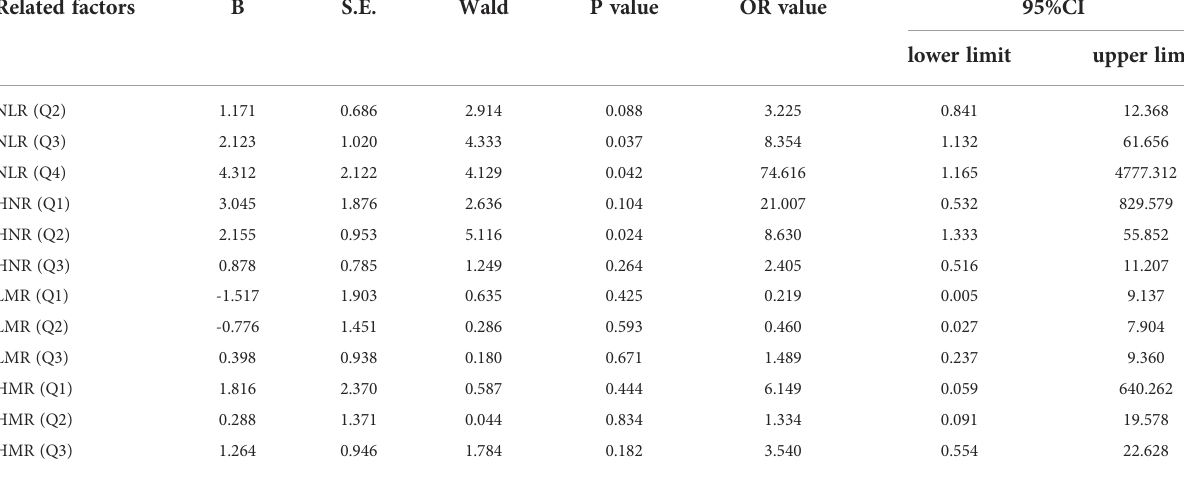
TABLE 8 Multivariate Logistic regression analysis of N L R, LMR, HNR, H N R and HMR (classi fi ed four groups) in the prediction of NSCLC metastasis. Related